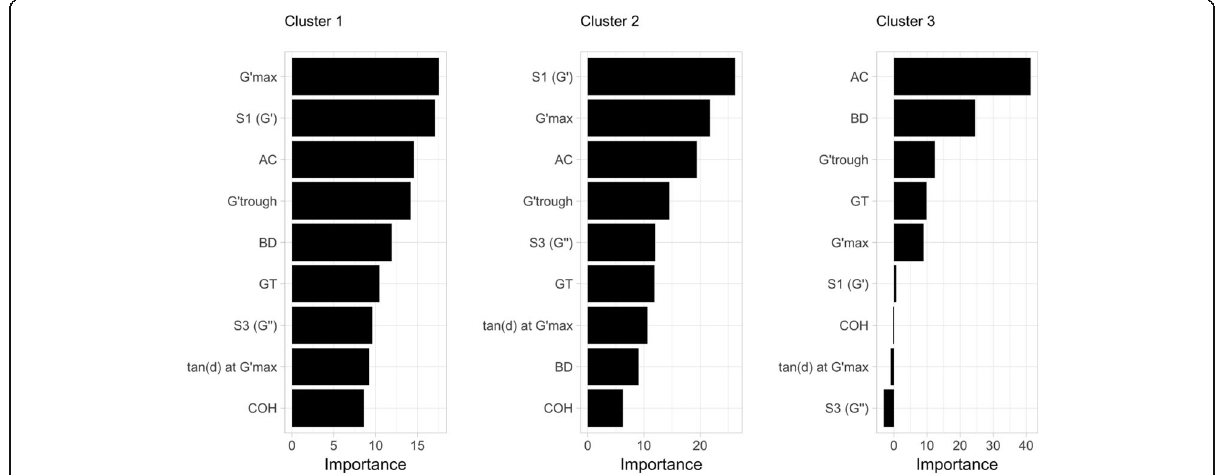
Fig. 4 Importance of the nine grain quality variables included in the final MLR model in each cluster, as calculated using Random Forests